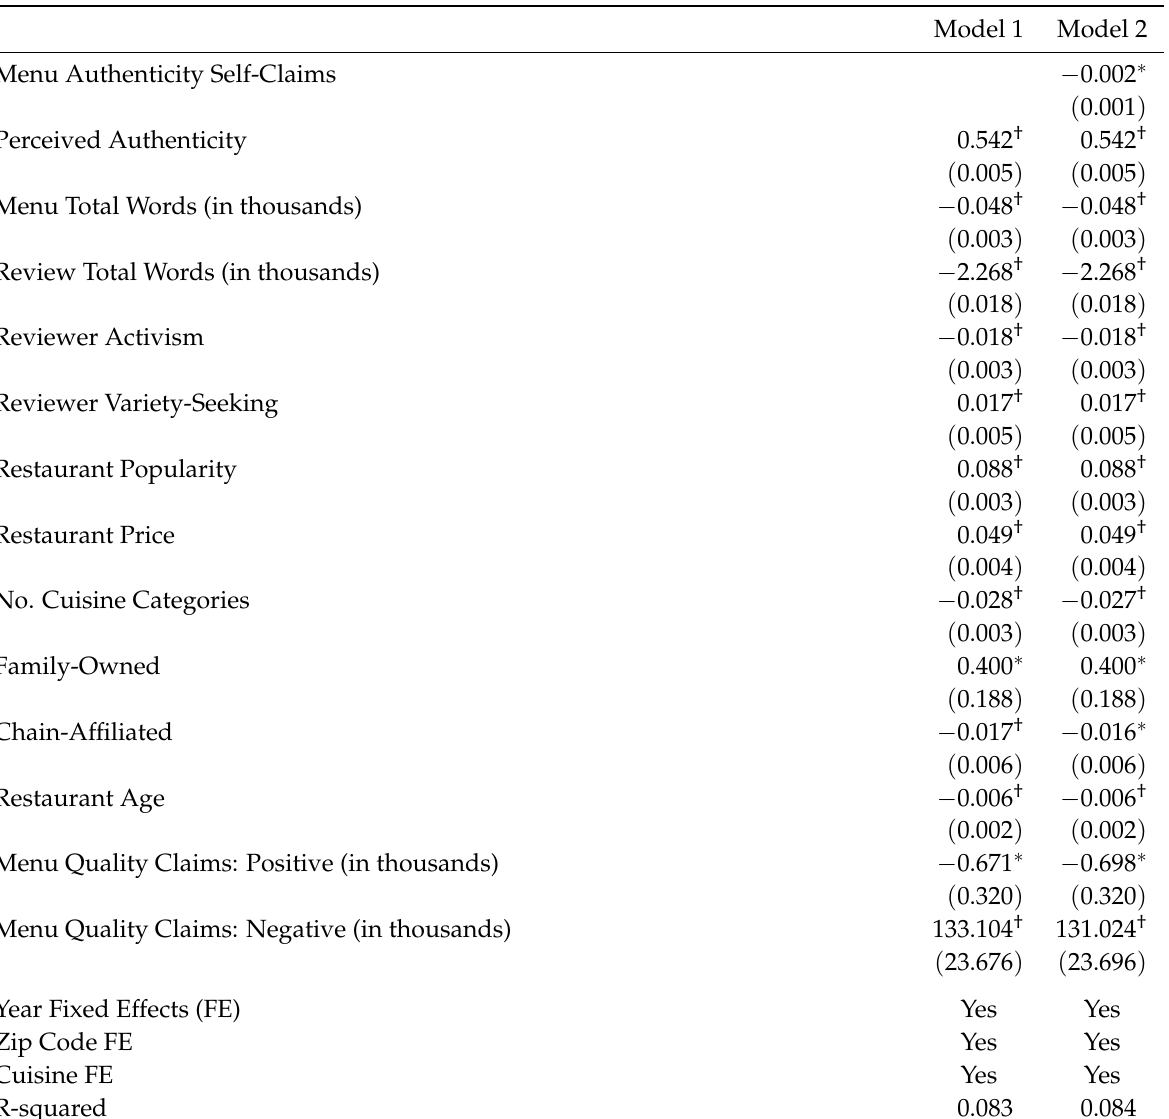
Table 2: OLS estimates of value ratings (study